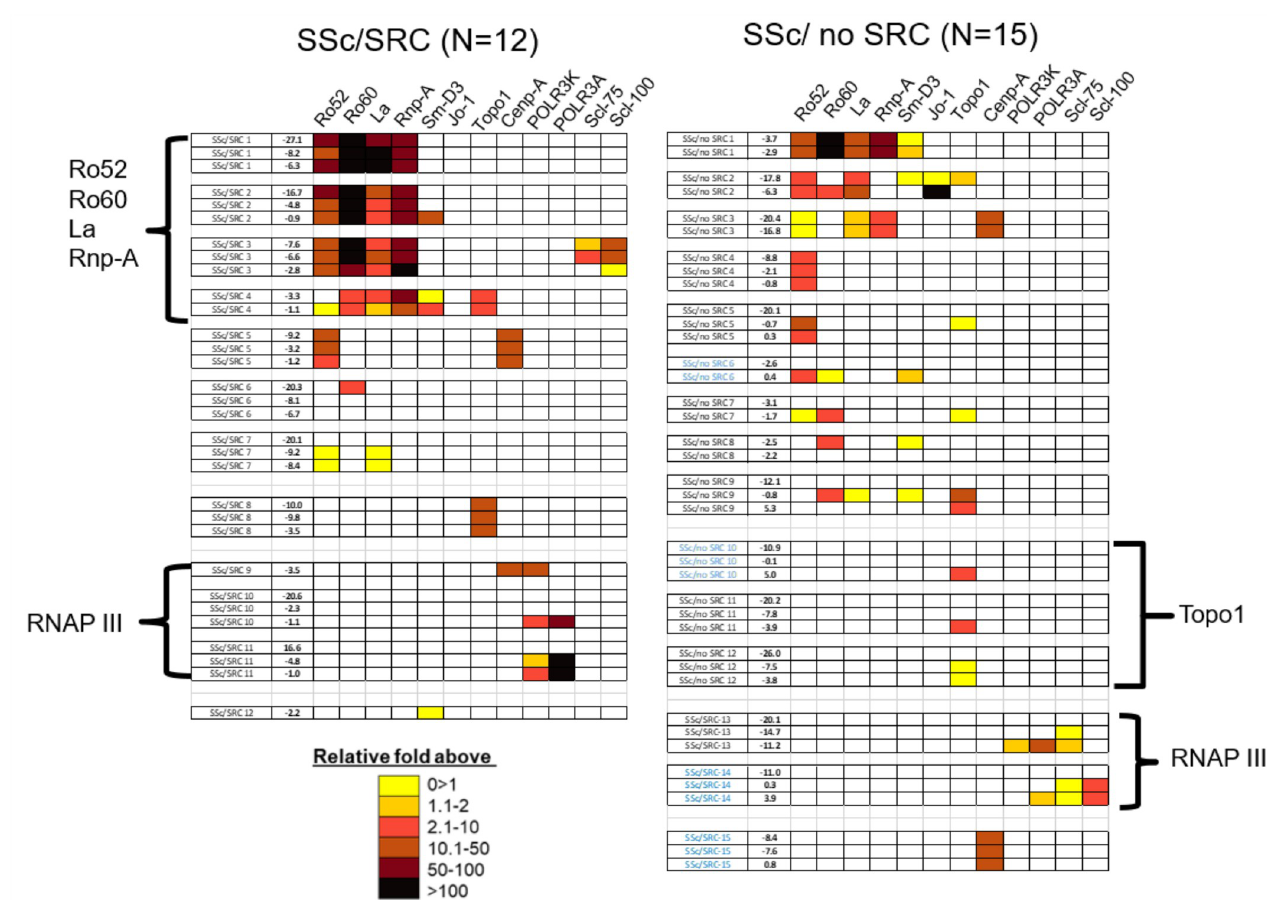
Fig 3. Heatmap analysis of autoantibodies in the SSc/SRC and SSc/no SRC cases. Heatmap analysis of autoantibody responses are shown in the 12 seropositive SSc/SRC and 15 seropositive SSc/no SRC subjects. For each case, the time in years before (-) or after (+) initial systemic sclerosis diagnosis is denoted in the column on the left. Each group of rows represents the autoantibody profile in a single case, in which the blue colored codes represent SSc cases with autoantibodies detected after diagnosis. Color coding denotes relative antibody levels above the baseline cut-off value and the clear boxes represent seronegative responses with the autoantigens in a given subject. As shown by the key, seropositive autoantibody levels in the subjects ranged from low levels (yellow) to extremely high autoantibody levels (black). Based on the patterns that emerged, the SSc/no SRC and SSc/SRC subjects were then manually segregated into three autoantibody clusters for Ro6o/Ro52/La/Rnp-A, Topo1 and RNAP III.